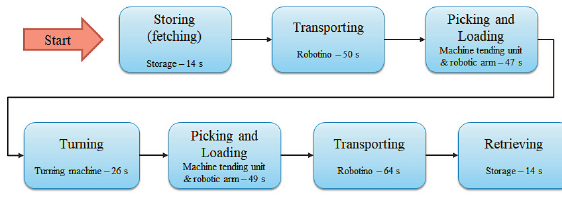
Fig. 5. Process flow of flexible manufacturing system.